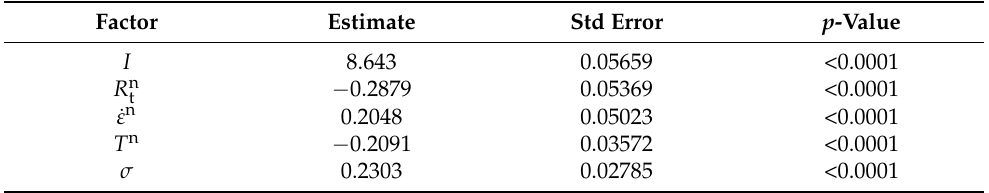
Figure 8. Variation of BIC during the iteration steps of the backward elimination algorithm for the low F en model. Table 10. Coefficients of the optimal model for the low F en data. Note that the normalized versions of the factors need to be used (Table